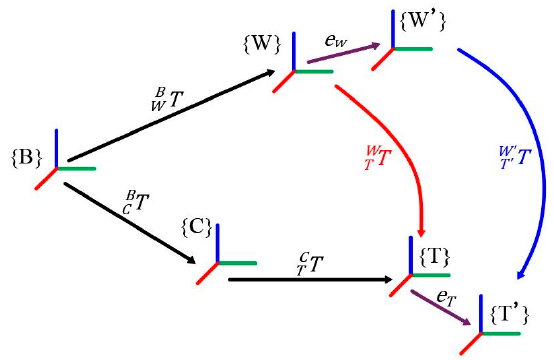
Figure 4. Errors during the attachment changing process.